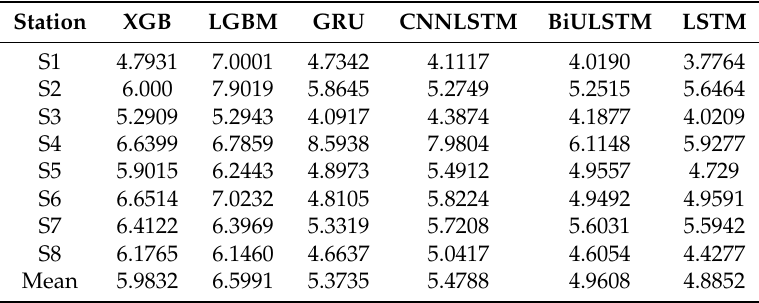
Table A2. Models results for RMSE (µg/m 3